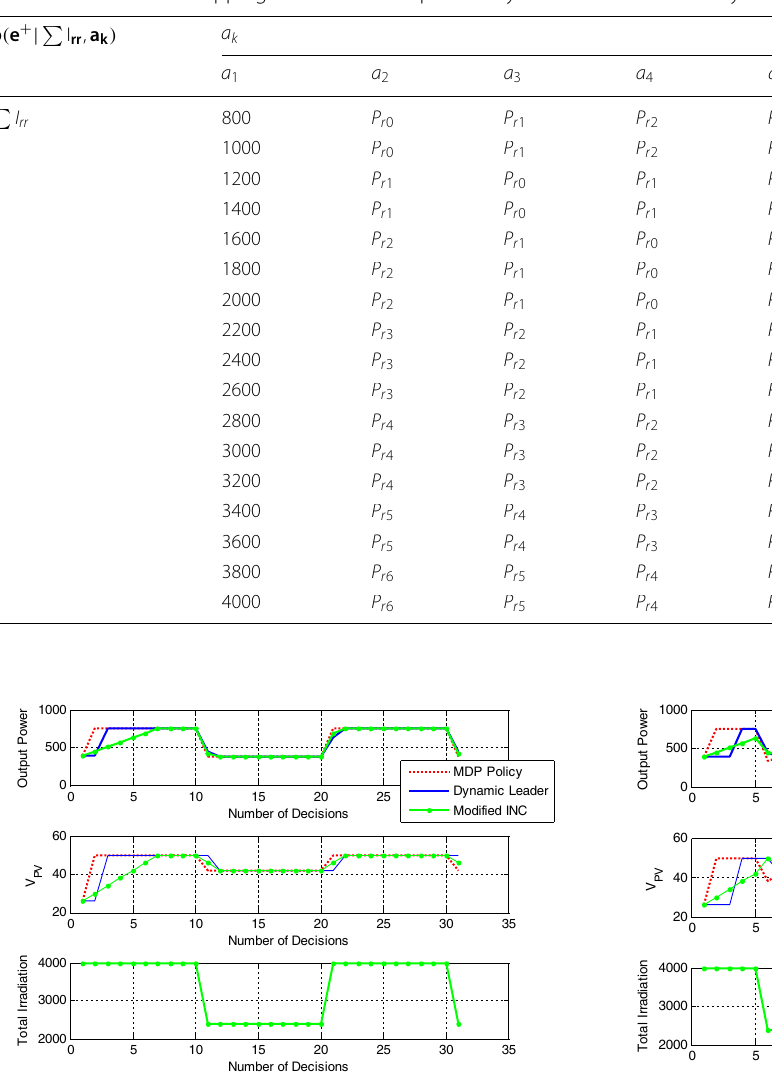
Table 3 Action-wise mapping of the transition probability values for the case study